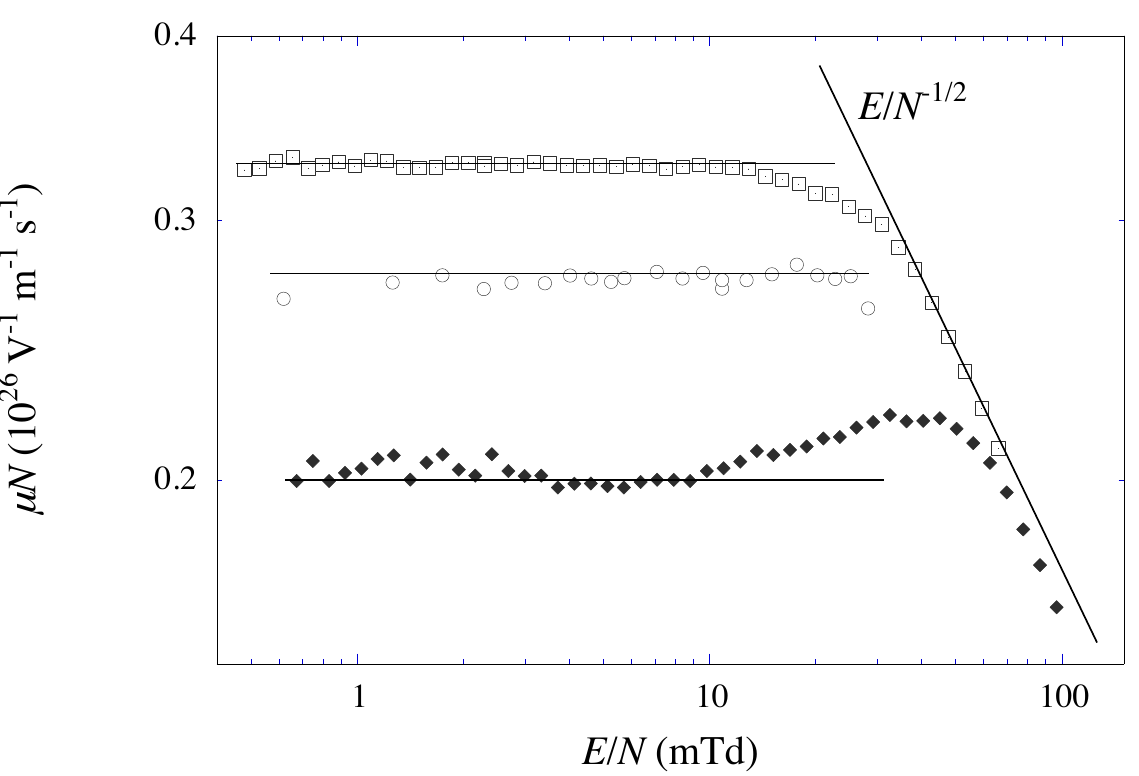
Figure 2. µ N vs. E / N at T = 26.1K for densities close to the onset of the electron self-trapping in bubbles. From top: N = 17.33, 19.47, and 22.76 in units of 10 26 m − 3 . 1mTd = 10 − 24 Vm 2 . The line ∝ ( E / N ) − 1/2 is the prediction of the classical kinetic theory for scattering of quasifree, epithermal electrons off hard spheres [26]. The presence of electron bubble states for the highest N is proven by the rise of µ N above its zero-field limit (shown as a constant line) before joining the high-field